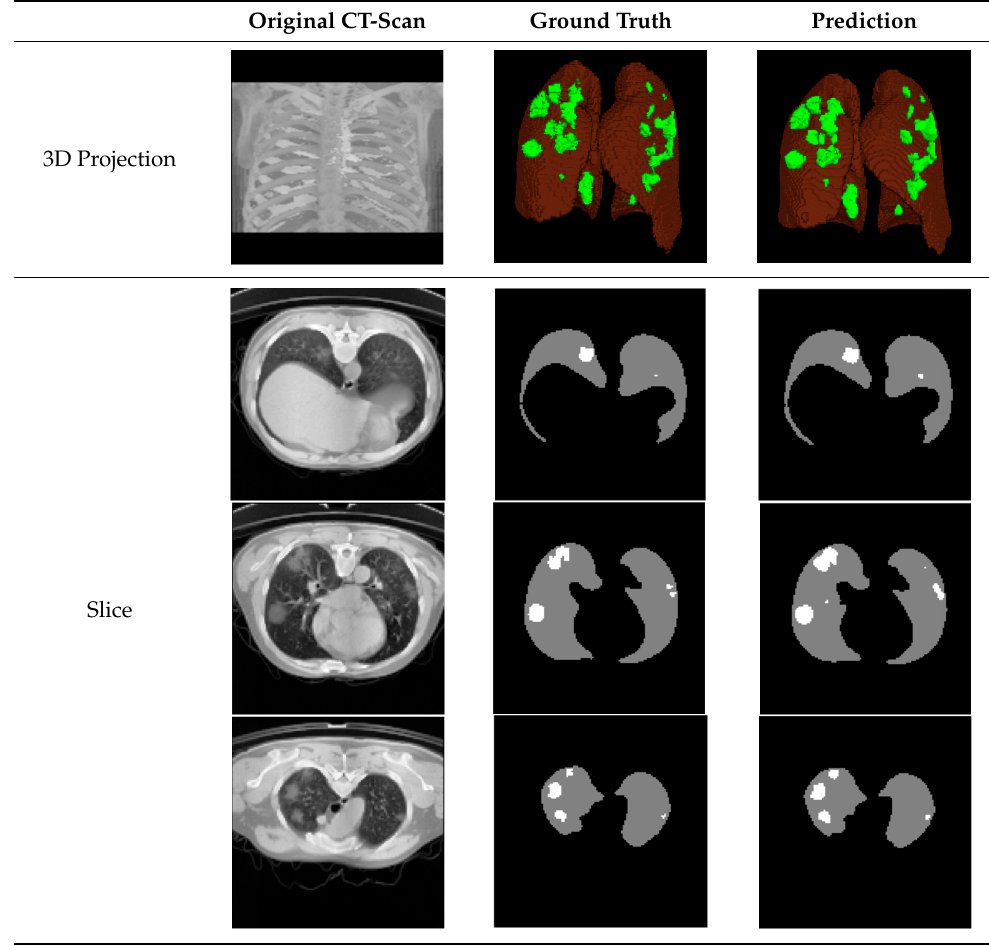
Figure 5. The training and validation loss curve of the 3D UNet architecture CT-scan binary-class segmentation learning process. Table 8. Comparison between ground truth and prediction results of lung and infection segmentation with 3D UNet architecture.